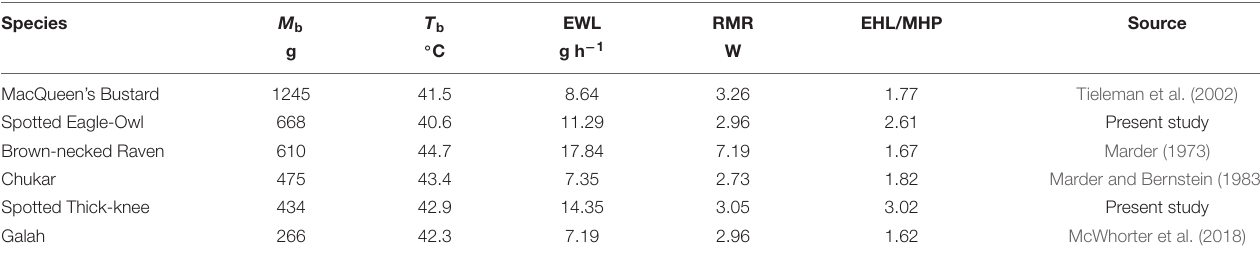
TABLE 4 | Comparison of body temperature ( T b ), evaporative water loss (EWL), resting metabolic rate (RMR) and ratio of evaporative heat loss (EHL) to metabolic heat production (MHP) at air temperatures ( T air ) of approximately 50 ◦ C in six species with body mass ( M b ) > 250 g: MacQueen’s bustard ( Chlamydotis macqueenii , n = 7), spotted eagle-owl ( Bubo africanus ), brown-necked raven ( Corvus ruficollis , n = 11–16), chukar ( Alectoris chukar ), spotted thick-knee ( Burhinus capensis ) and galah ( Eolophus roseicapilla , n = 7). Species M b T b EWL RMR EHL/MHP Source g ◦ C g h − 1 W